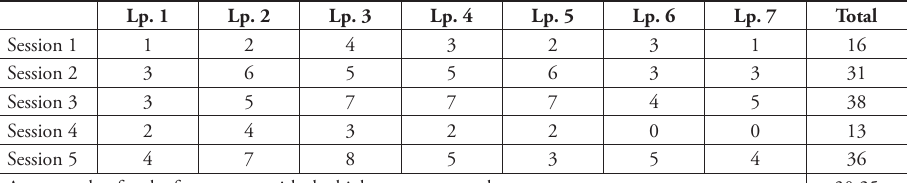
Table 3. Example of the calculation of the reference value for the monitoring of M. asper in one site. Ses- sions represent single evenings when the wood piles were checked. The numbers given in the columns